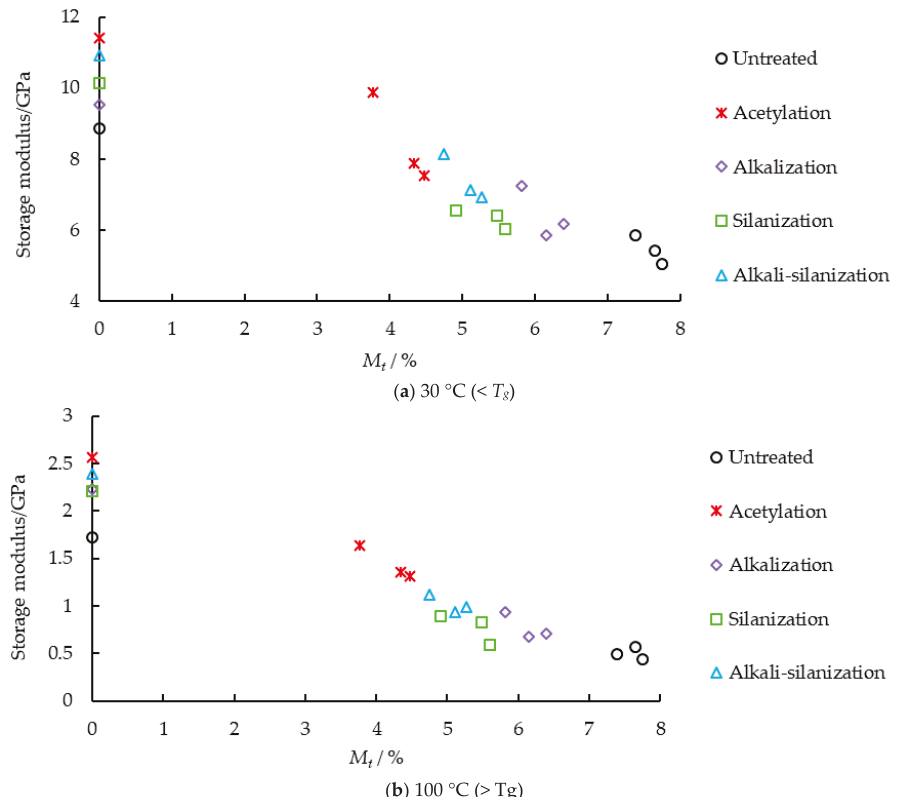
Figure 3. Storage modulus and loss factor of FFRP (Flax fiber Reinforced Polymer) after hygrothermal aging.